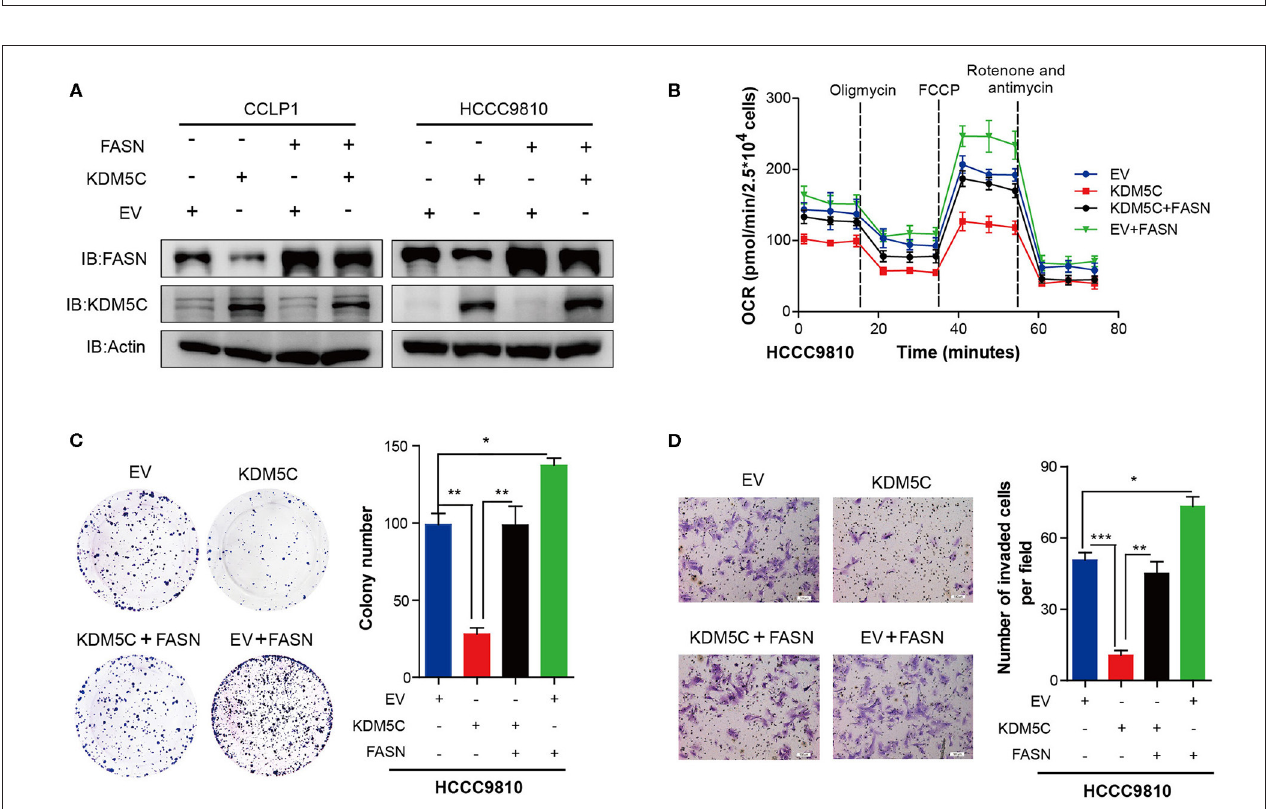
FIGURE 3 | HCCC9810 cells upon overexpression of KDM5C using cell cycle checkpoint-associated signatures (B,C) , liver cancer proliferation-associated upregulated or downregulated signatures (D,E) , an invasion-associated signature (F) and fatty acetyl-CoA biosynthesis-associated signatures (G,H) . (I) Heatmap showing the differentially expressed genes of HCCC9810 cells upon overexpression of KDM5C, which focused on a set of genes of fatty acid metabolism. (J,K) FASN expression after KDM5C overexpression (in CCLP1 and HCCC9810 cells) and KDM5C knockdown (in CCLP1 and HCCC9810 cells) (J) , relative FASN protein levels were normalized against β -actin using paired t -test and EV acted as control (K) . (L) Cellular free fatty acid was measured in HCCC9810 and CCLP1 cells with EV or KDM5C overexpressed. (M) Oxygen consumption rates (OCR) were measured after KDM5C overexpression in HCCC9810 cells. Data are presented as the mean ±